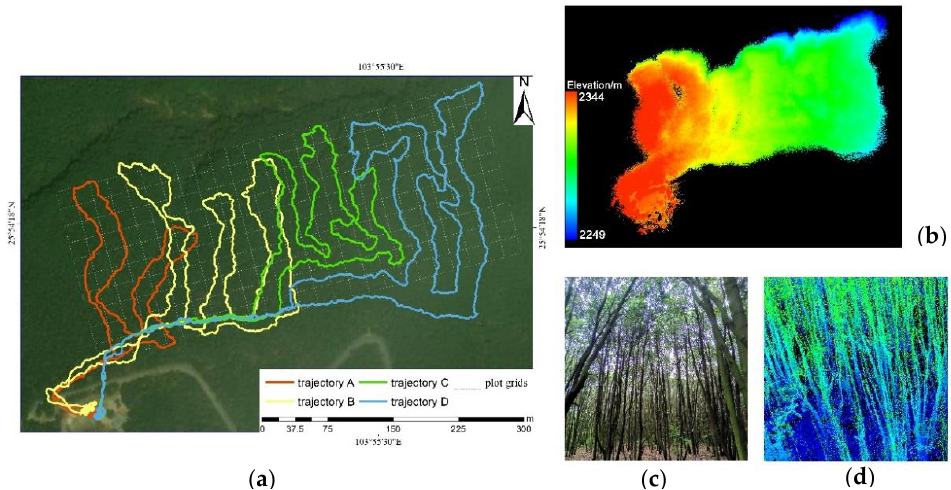
Figure 1. Situation in the forest plot and lidar data acquisition results. ( a ) Grids in the large forest plot and trajectories of multiple lidar scans. ( b ) Lidar point cloud data displayed by height. ( c ) Real scene in the forest plot and ( d ) the corresponding point cloud.